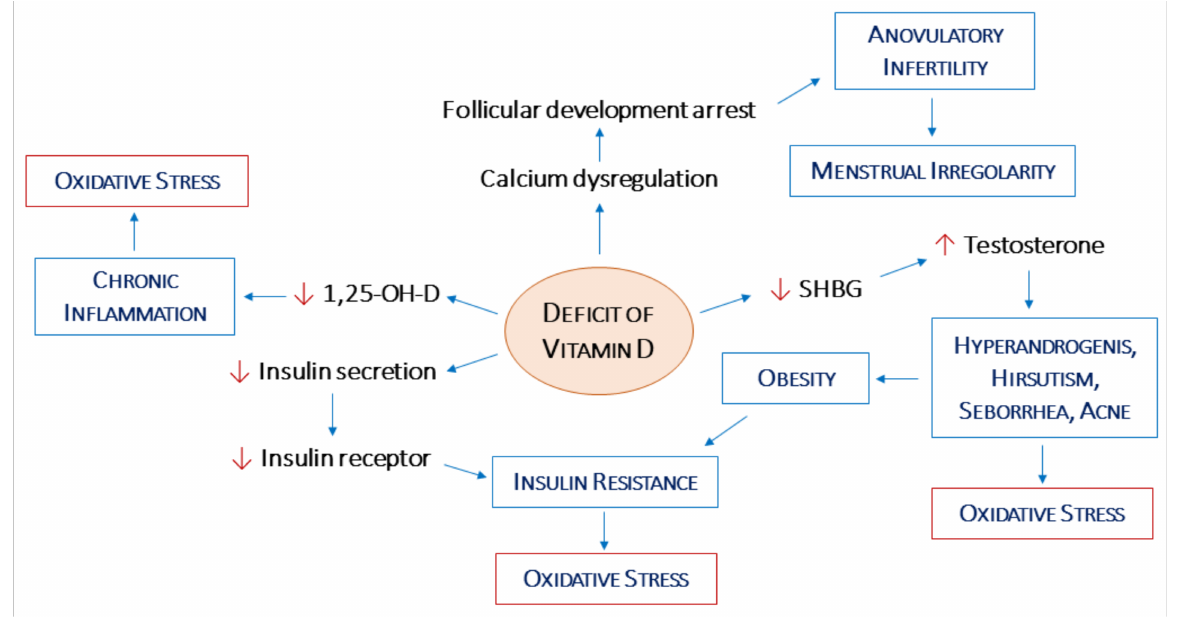
Figure 1. Relationship of vitamin D deficiency with the pathogenesis of insulin resistance and the metabolic syndrome in PCOS, hormonal alteration, and infertility. (1,25-OH-D: 1,25-hydroxyvitamin D; SHBG: Sex Hormone Binding